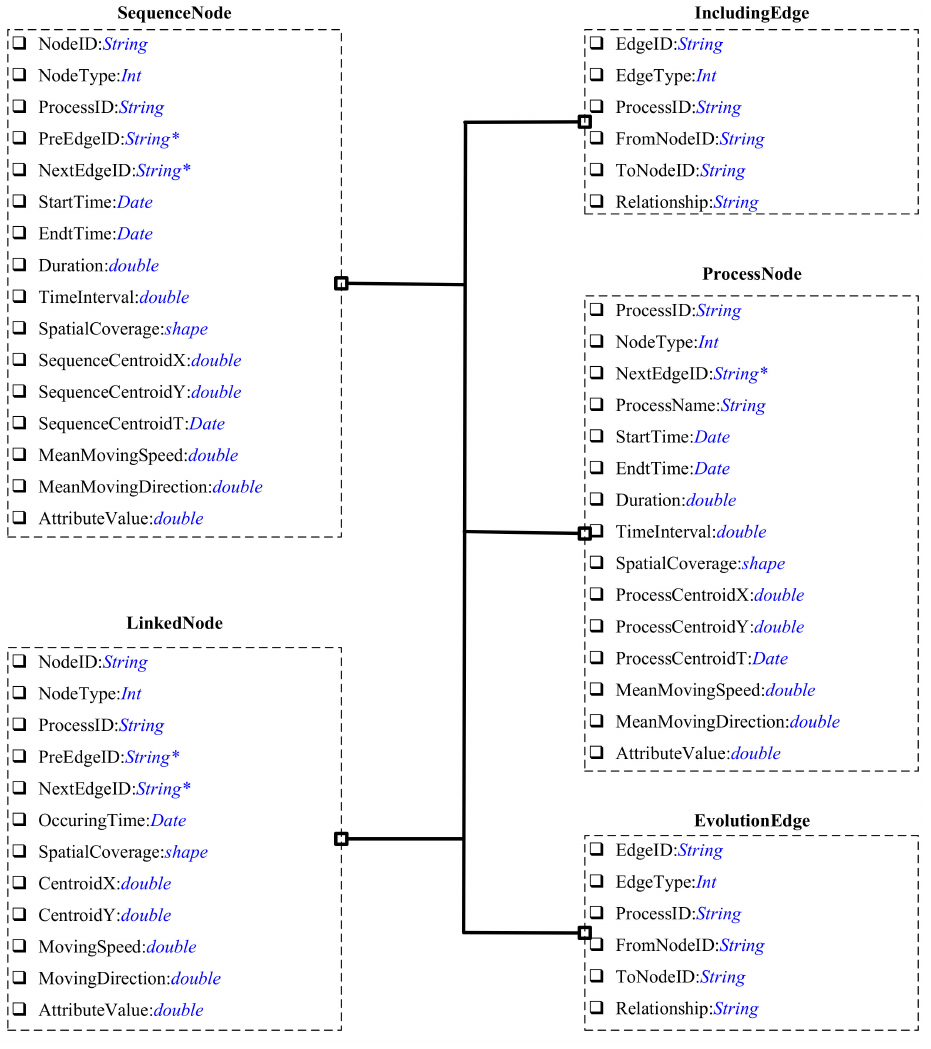
Figure 6. The storage of a process graph A: The process is linked by NodeID and EdgeID